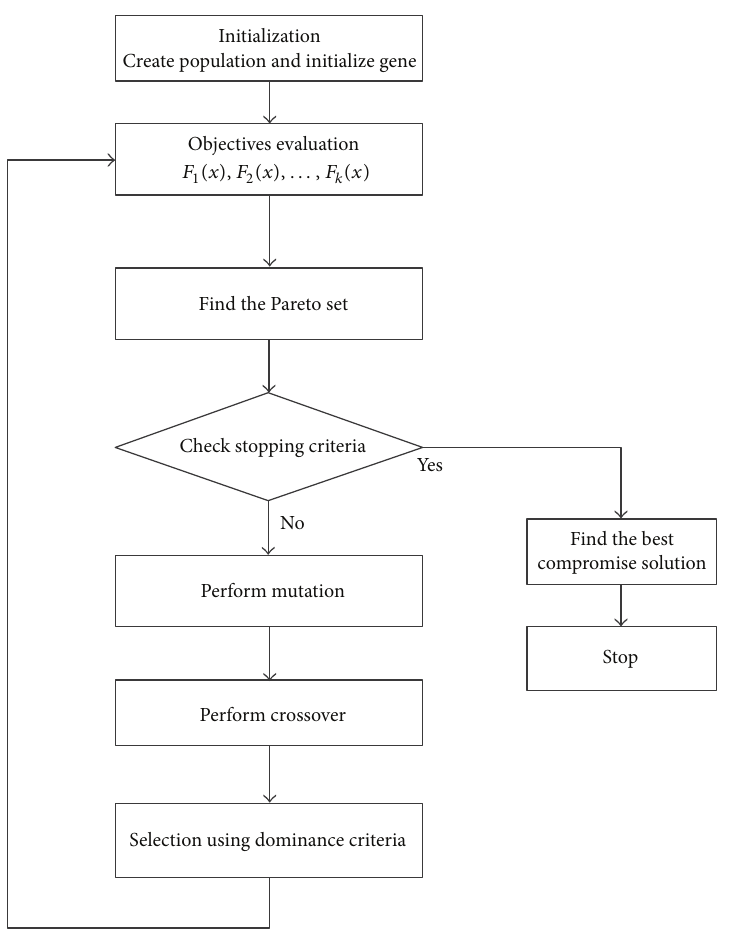
Figure 1: Flowchart of traditional Pareto-based